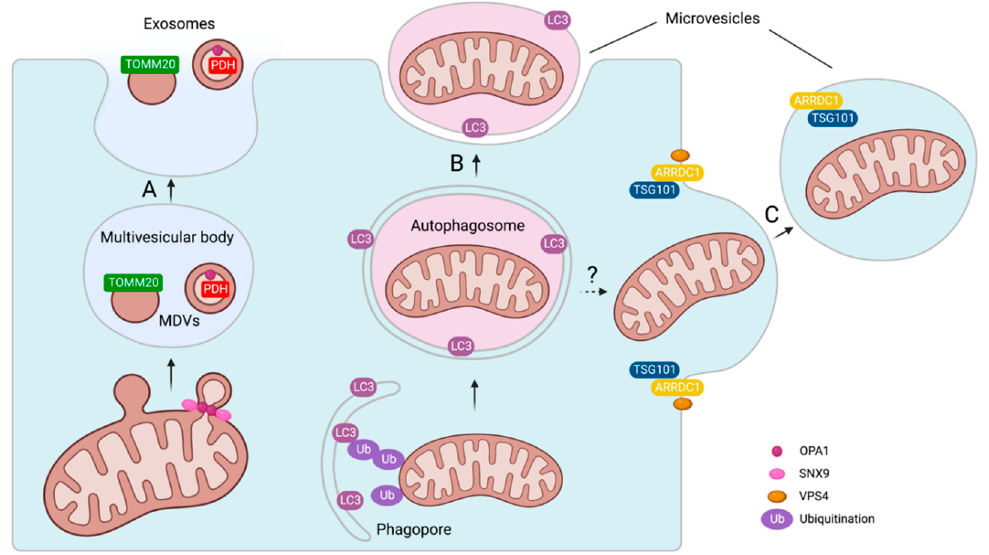
Figure 3. Mechanisms of mitochondrial cargo loading into extracellular vesicles and mitochondrial- derived vesicles (MDVs). ( A ) Fusion of MDV-containing multivesicular body with the plasma membrane leads to an exosomal release of stored MDVs. ( B ) Mitochondria in LC3-positive au- tophagosomes could be secreted as microvesicles via fusion of the outer phagosomal membrane with the plasma membrane (question mark indicates a possible pathway) or ( C ) through outward budding of the plasma membrane mediated by ARRDC1 and TSG101. Created with BioRender.com.